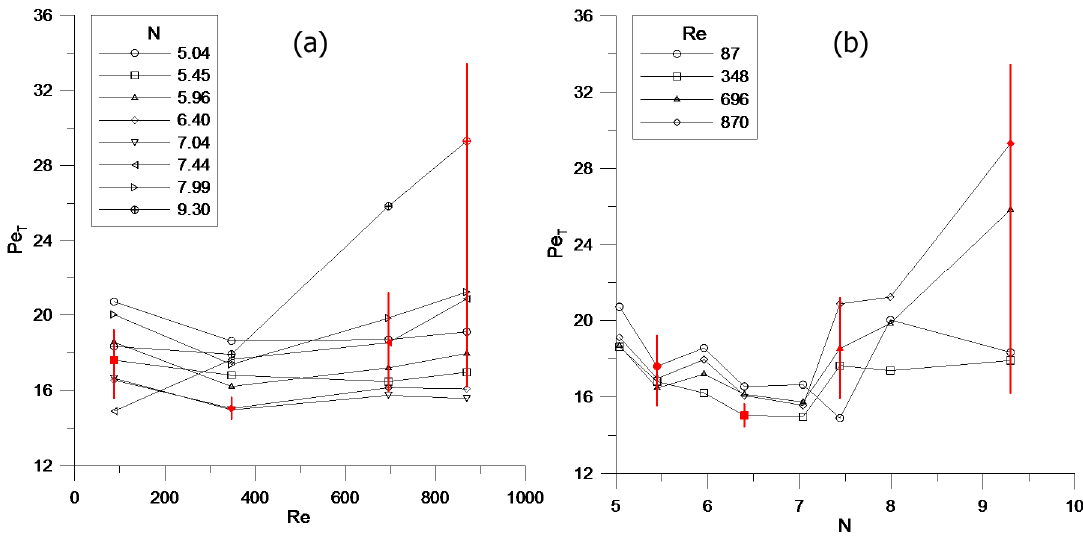
Figure 16. Variation of parameter Pe T against ( a ) Re for all values of N ; and ( b ) N for all values of Re.